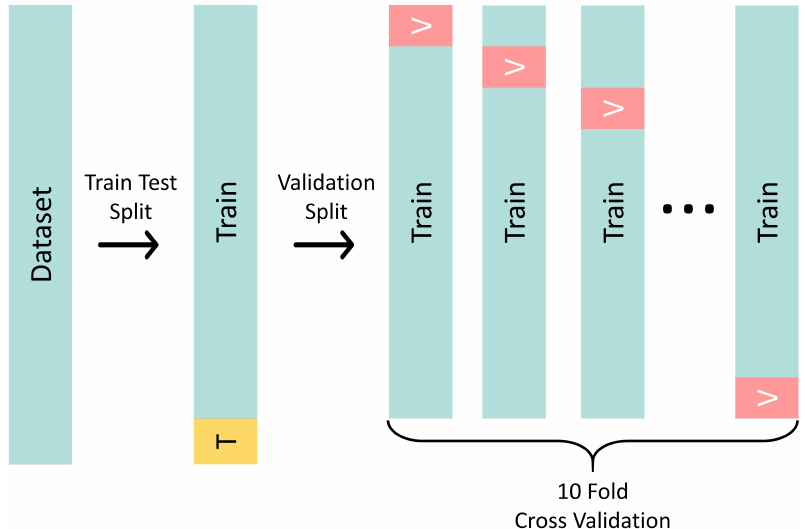
Figure 2. Train-test cross-validation split methodology used in this paper. The first operation applied is a train-test split that randomly separates 90% of the data as training and 10% for testing. The second operation is a validation split that uses only the train split of the previous step and produces ten different folds of training and validation